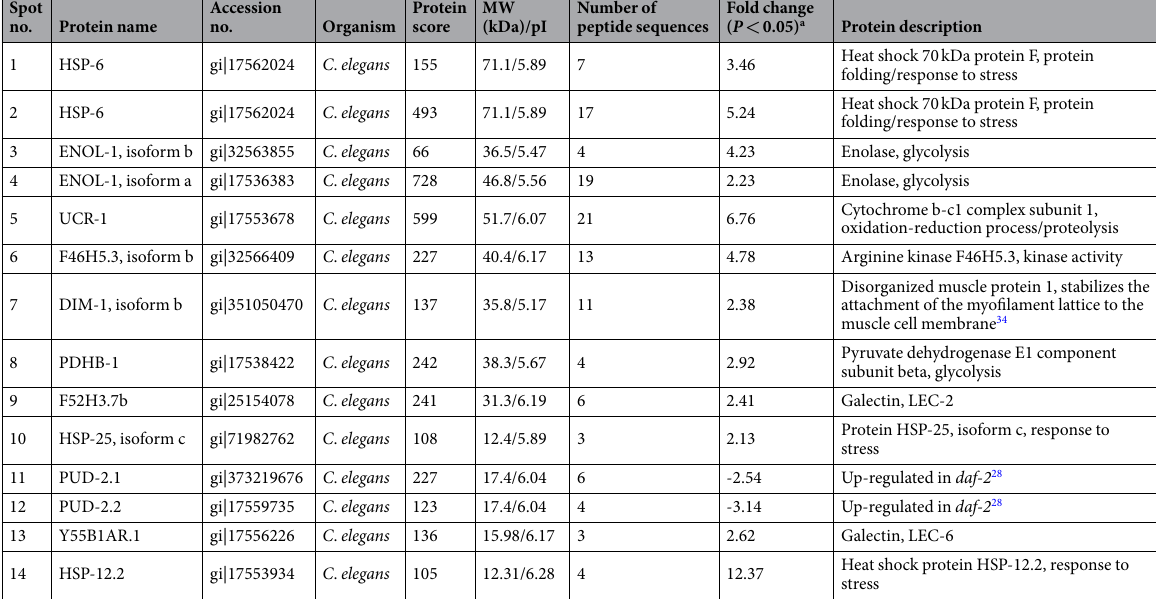
Table 1. Identification of the proteins differentially expressed in C . elegans when exposed to Cry6Aa2 toxin. a Numbers indicate fold-changes for up-regulated and down-regulated ( − )